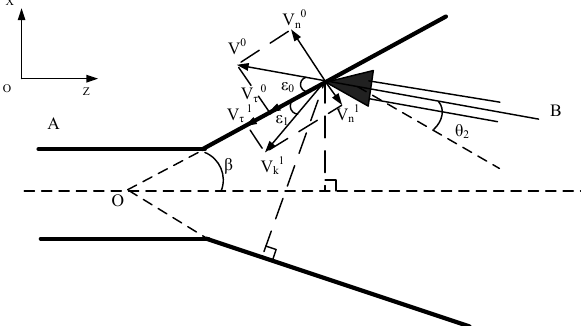
Figure 1. The traditional study of the contact between the pin and the chamfered hole, both of which are considered rigid.